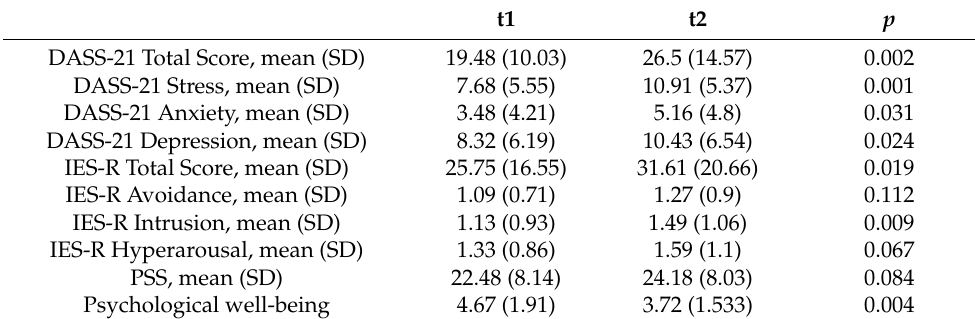
Table 3. Psychometric assessment at t1 and